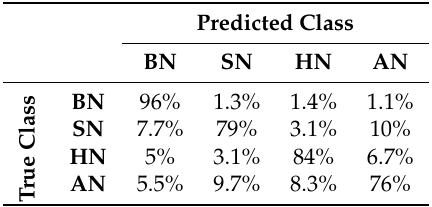
Table 8. Results achieved Multi-headed 2D